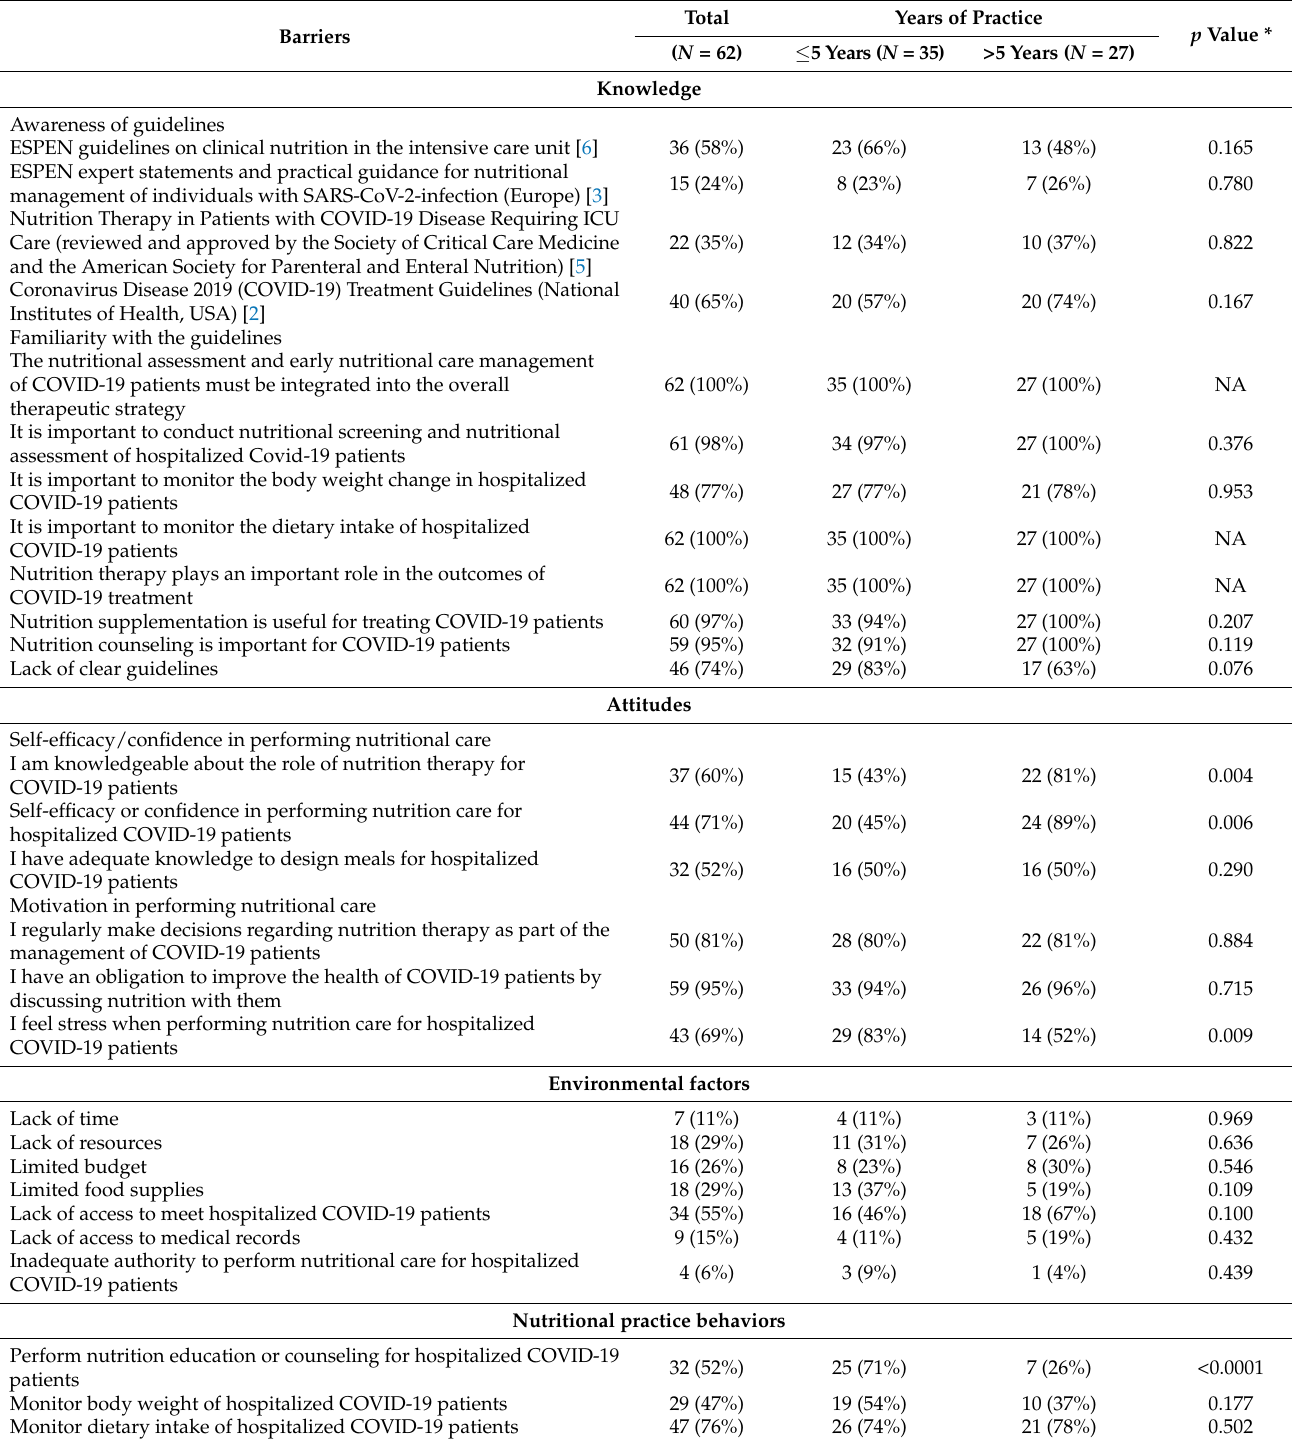
Table 3. Barriers to dietician adherence to nutritional guidelines in relation to nutritional practice behaviors of hospitalized COVID-19